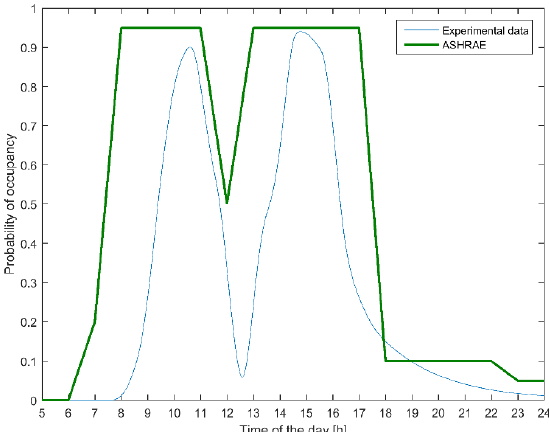
Figure 2. Comparing Occupancy profiles from the ASHRAE 90.1 2004 reference to current study.